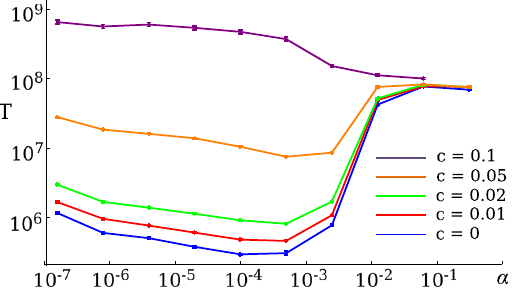
Figure 5. Mean adaptation time T plotted versus the switching rate α , for different fitness costs c = {0, 0.01, 0.02, 0.05, 0.1} of phenotype B and for parameters K = 100, μ = 10 − 5 , δ = 0.9 and d = 0.1.